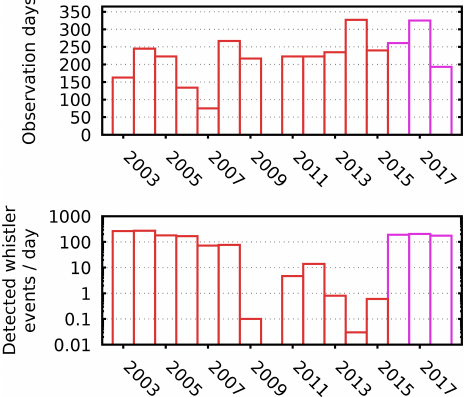
Figure 20. Number of days the AWDA whistler detector was active in a given year (top) and the average daily rate of detected whistler events (singular or group whistlers) at Nagycenk (2003–2015, in red) and at the temporary station at Muck in the Sopron Mountains (2016 onwards, in magenta). The drop in the daily rate of detections (from a maximum of around 260) is due to increasing electromag- netic noise originating outside of the observatory’s